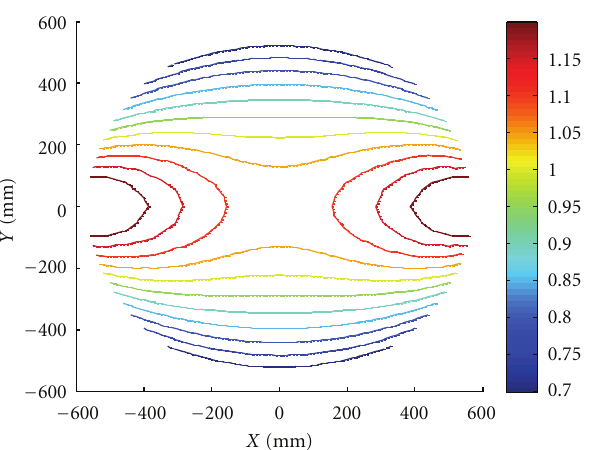
Figure 12: DSI μ Z in the YZ plane ( X =